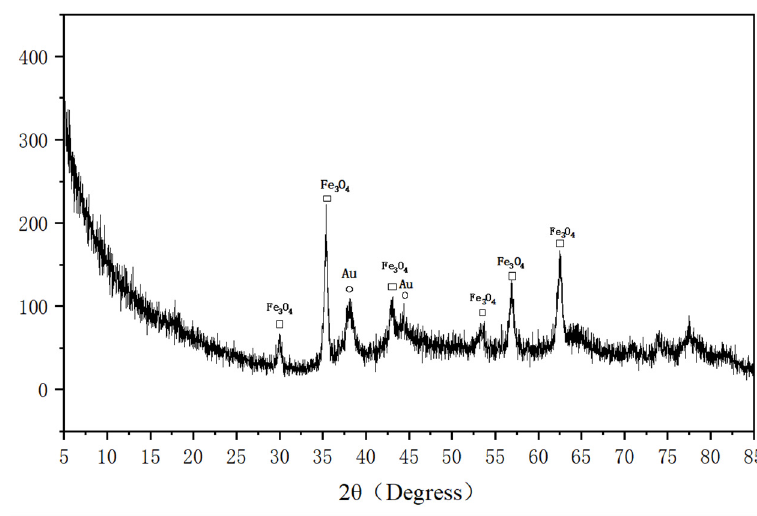
Figure 2. XRD patterns of Fe 3 O 4 @PDA@Au@GO.